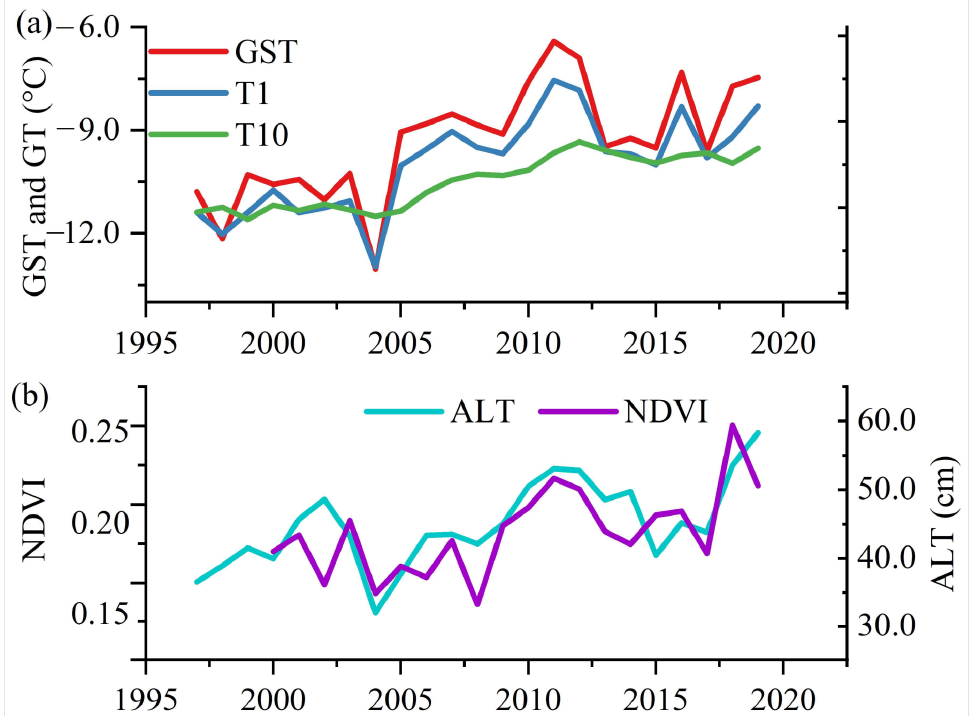
Figure 6. Dynamic of ground surface temperatures (GST) and ground temperatures (T1 and T10), active layer thickness (ALT) in 1997–2019 and NDVI in 2000–2020 at Saskylakh, Anabarsky District, the Sakha Republic, Russia. Notes: ( a ) shows the ground surface temperature at the depth of 5 cm (GST) and ground temperature at depths of 1 and 10 m (T1 and T10); ( b ) shows the normalized difference vegetation index (NDVI, − 1~1) and active layer thickness